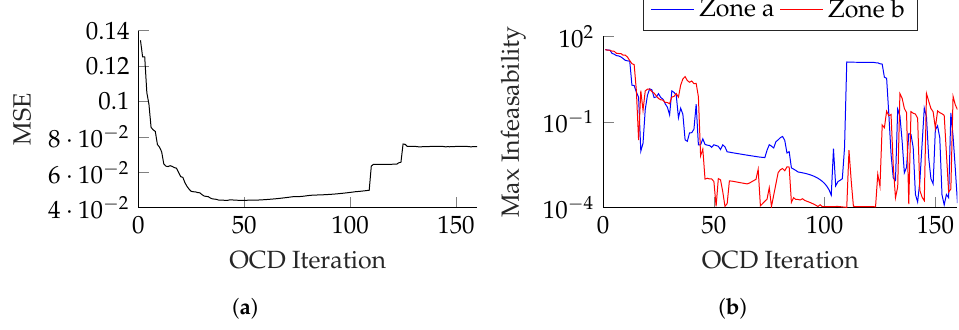
Figure 7. Eight-node network with the marginal bid price c e Hydraulic Pre-Calculation. ( a ) MSE as defined in (32). ( b ) Maximum infeasability per